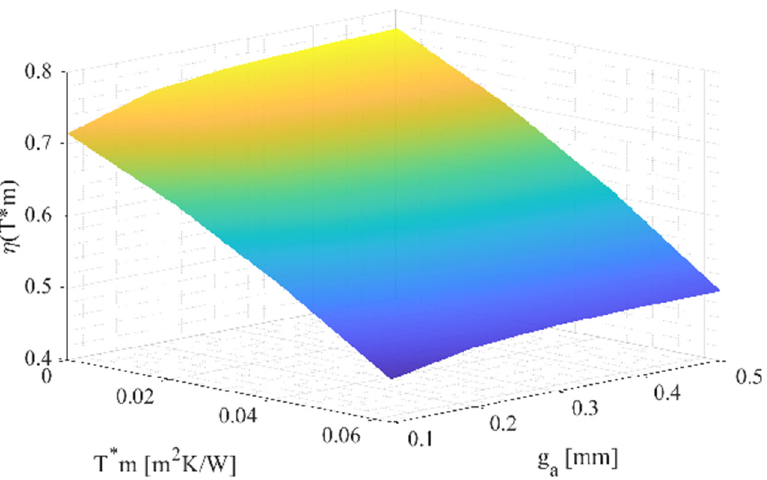
Figure 12. Characteristic thermal efficiency curve (cid:2015)((cid:1846) ∗ (cid:1865)) as a function of the absorber plate thickness.